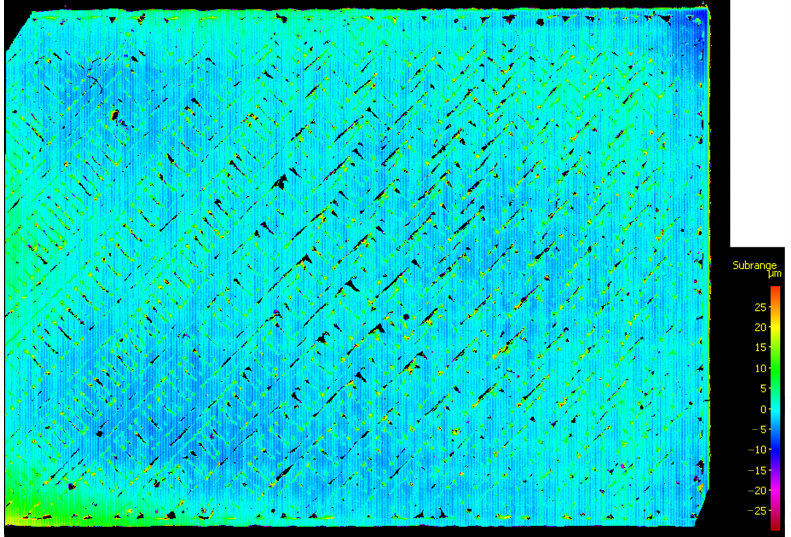
Figure 13. Form removed surface plot of ABS sample using Alicona scan